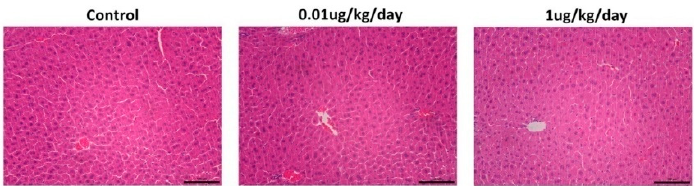
Figure 2. Effects of low-dose OP on liver morphology in mice. Representative images of haematoxylin-eosin (HE) staining in mice liver tissues. No obvious morphological damage was observed in the livers of OP-treated mice. Scale bar = 100 μ m.